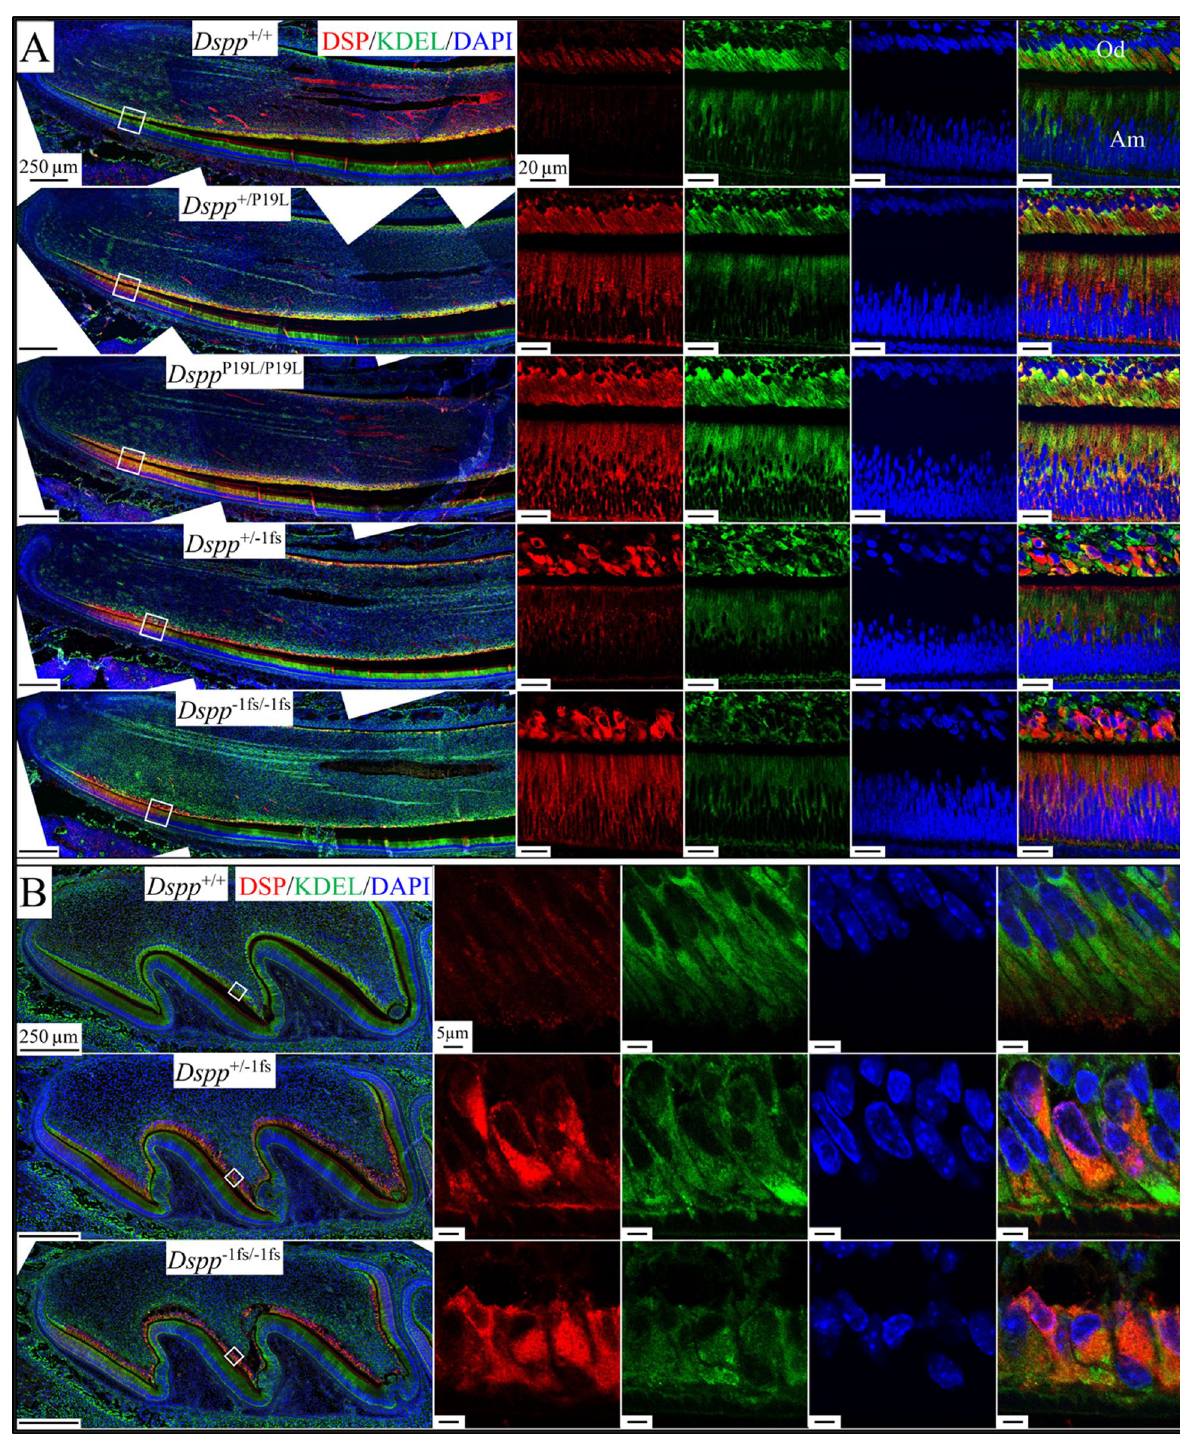
Figure 5. Endoplasmic reticulum (ER) retention of DSPP within the odontoblasts and ameloblasts of Dspp P19L and Dspp −1fs mice. Immunohistochemistry on D14 mandibular incisors (A) and D3 maxillary 1st molars (B), showing DSP (red), KDEL (green; ER), and DAPI (blue; nucleus). Scale bars: 250 µm (left)/20 μm (right). ( A ) In Dspp P19L incisors, DSP and KDEL signals in odontoblasts and presecretory ameloblasts overlap, indicating moderate retention of the p.P19L DSPP protein in the ER. In Dspp −1fs incisor odontoblasts, the intracellular DSP predominates over the KDEL signal indicating very high accumulation of the -1 frameshifted DSPP in the ER. Od, odontoblast; Am, ameloblast. ( B ) In Dspp +/+ molar odontoblasts, KDEL signal is distributed throughout cytoplasm at medium intensity with minimal overlapping DSP signal. In Dspp −1fs molar odontoblasts, the DSP and KDEL signals overlap indicating retention of the -1 frameshifted DSPP protein in the ER, whereas there is minimal accumulation of the -1 frameshifted DSPP protein in presecretory ameloblasts. See also Figure